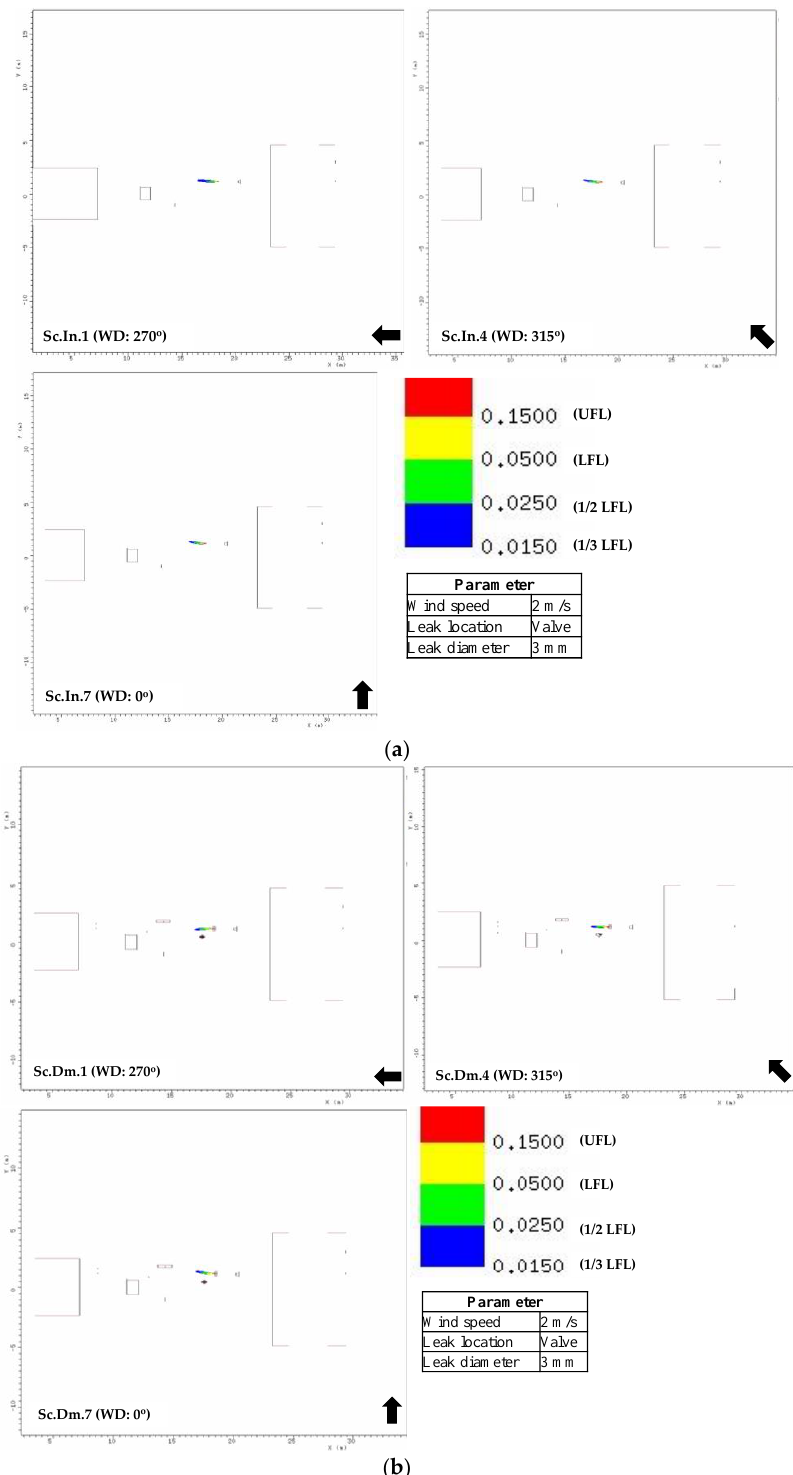
Figure 16. Gas contour plot for the 3 mm valve leak at 2 m/s for ( a ) intact and ( b ) damaged ships.